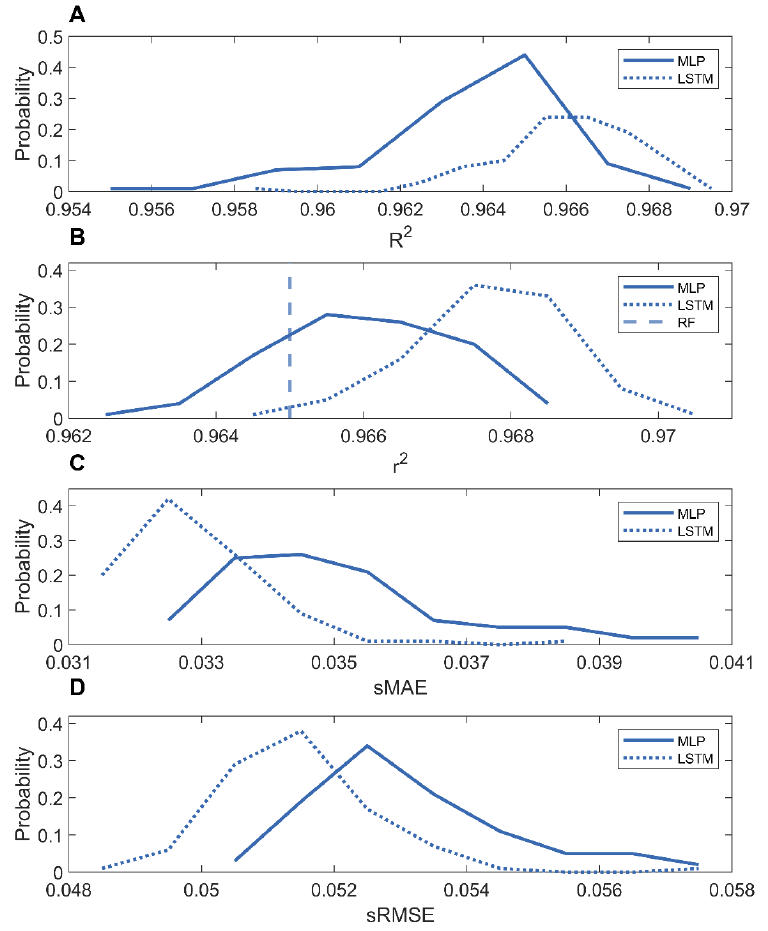
Figure 6. Distributions of performance metrics r 2 ( A ); R 2 ( B ); sMAE ( C ); and sRMSE ( D ) of LSTM (dotted curves) and MLP (solid curves) models trained on the mixture of MOFs and COFs. The reported r 2 of random forest models [36] are shown as the vertical dashed line.